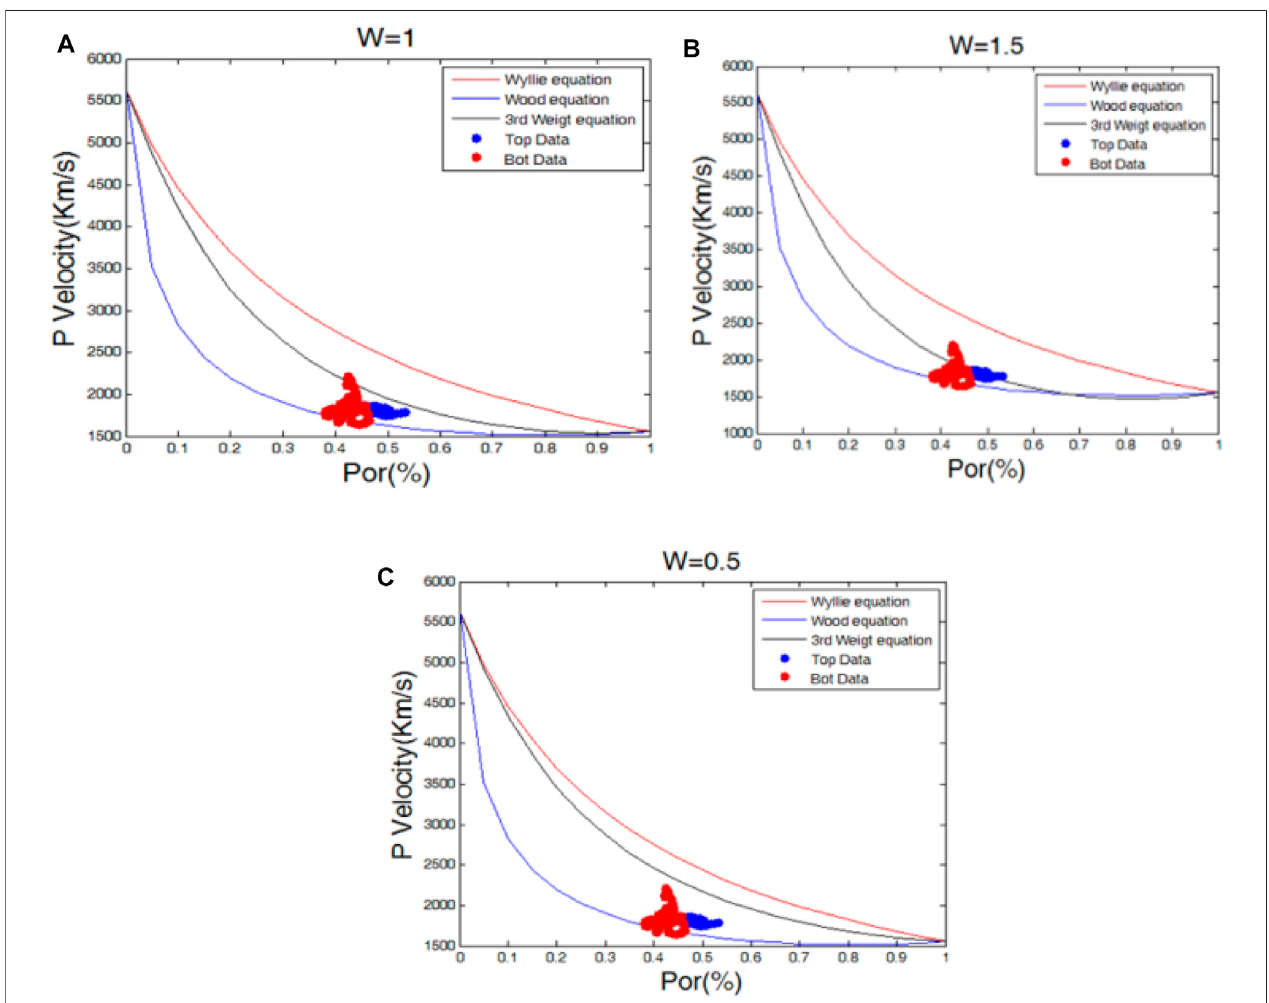
FIGURE 3 | Selection of formation consolidation factor W for three-phase weighting equation.